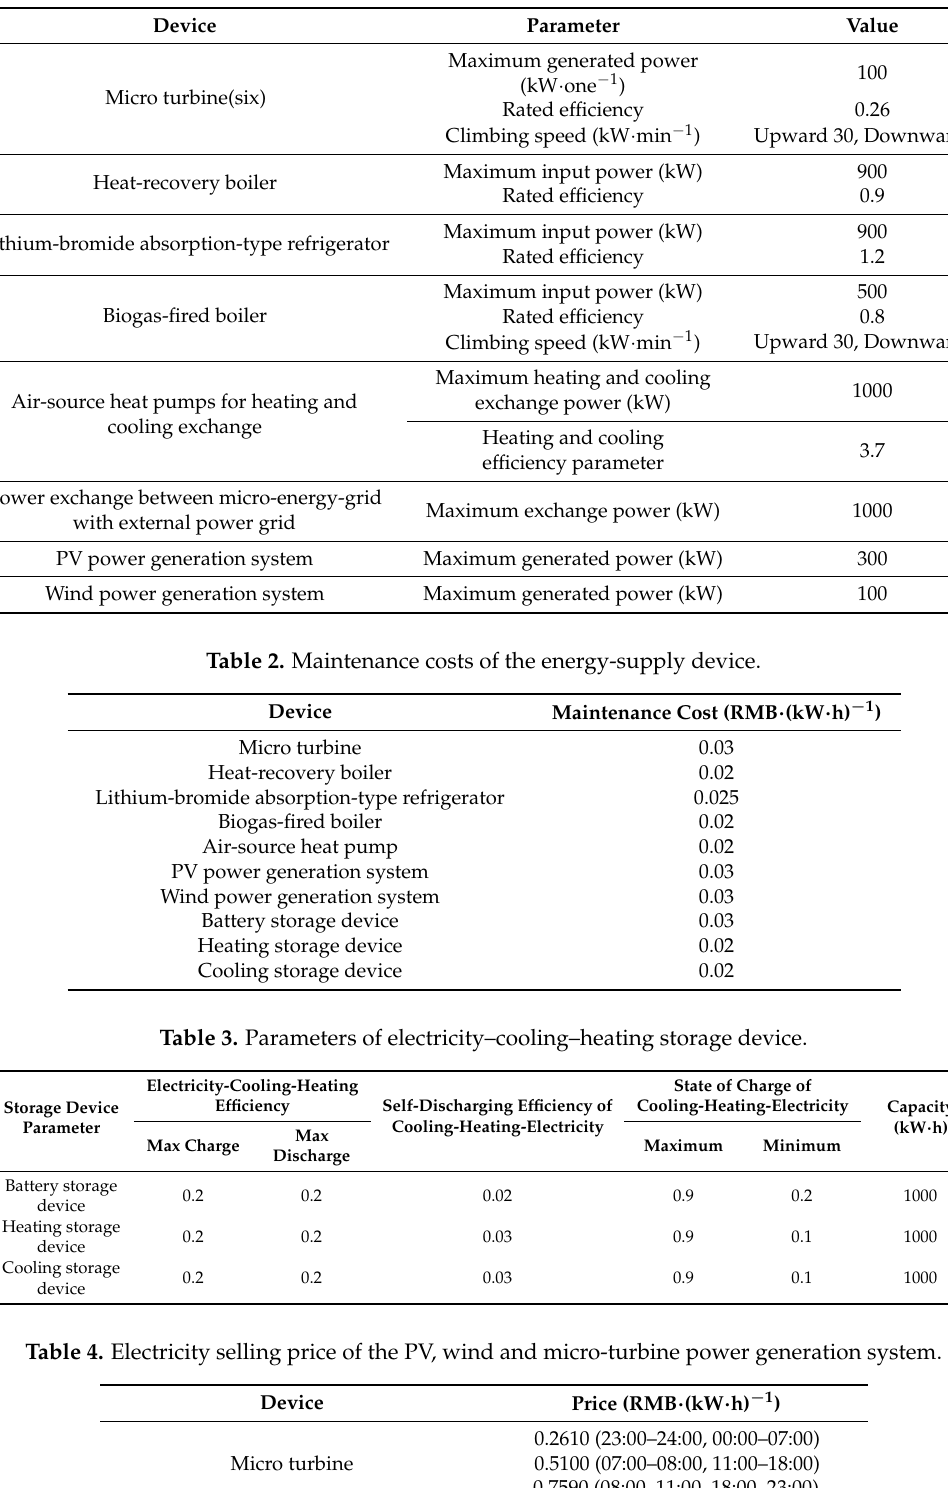
Table 1. Parameters of the energy-supply device of the micro-energy-grid.